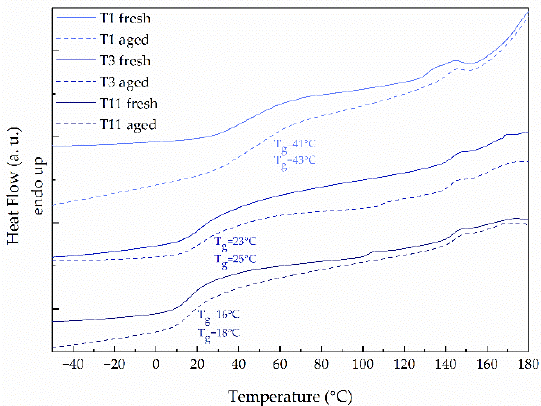
Figure 6. DSC thermograms of fresh and aged 3DP tablets made from filaments containing 20%, 40%, or 50% of KET with the addition of crospovidone.